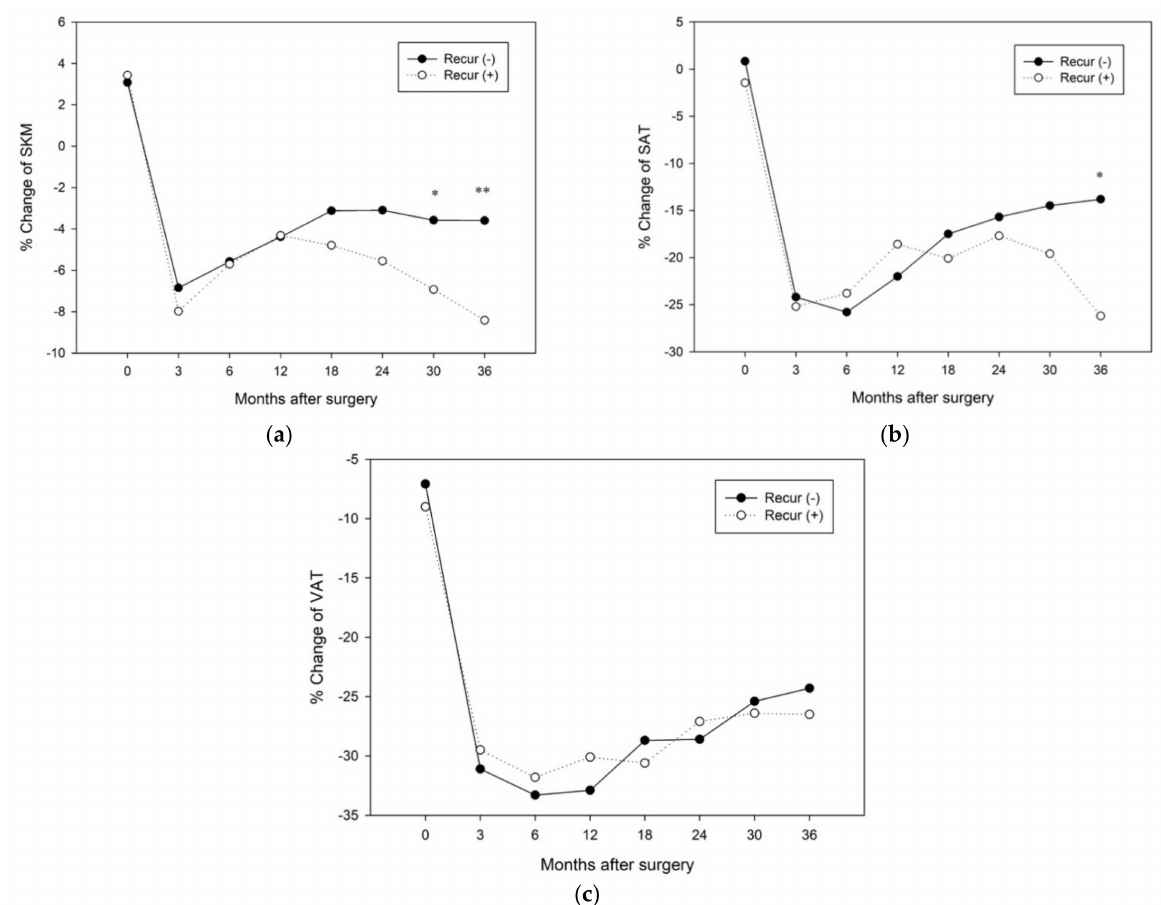
Figure 4. Change in longitudinal body composition according to recurrence: ( a ) % change of skeletal muscle mass (SKM) after surgery; ( b ) % change of subcutaneous adipose tissue (SAT) after surgery; ( c ) % change of visceral adipose tissue (VAT) after surgery. Statistical significance between groups (Student’s t -test; * p < 0.05, ** p <